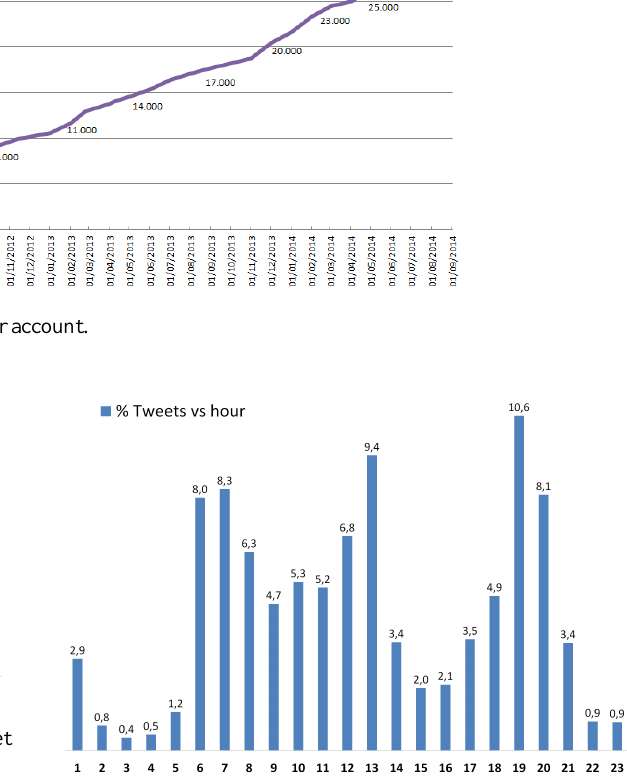
Figure 8. Hourly distribution of tweets posted by Euskalmet (from July 2011 to August